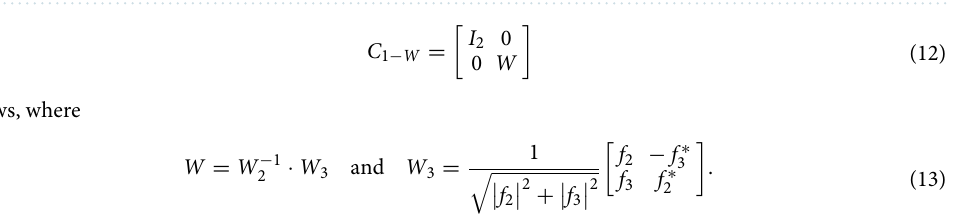
Figure 3. Quantum circuit for three qubits using the full Hilbert space. The three qubits is initialized to 00 0 a e , and the qubit e can be rotated to an arbitrary state | � | � four UE-parameters, similar to U F in Fig. 1. Then four controlled-controlled operators are applied to generate the four UE-terms, where the first dashed one is unnecessary in practice. Next, two Hadamard gates are applied to the ancillary qubits to superpose the four UE-terms. Finally, measurements are performed on the ancillary qudits to simulate F ( t ) in an indeterministic